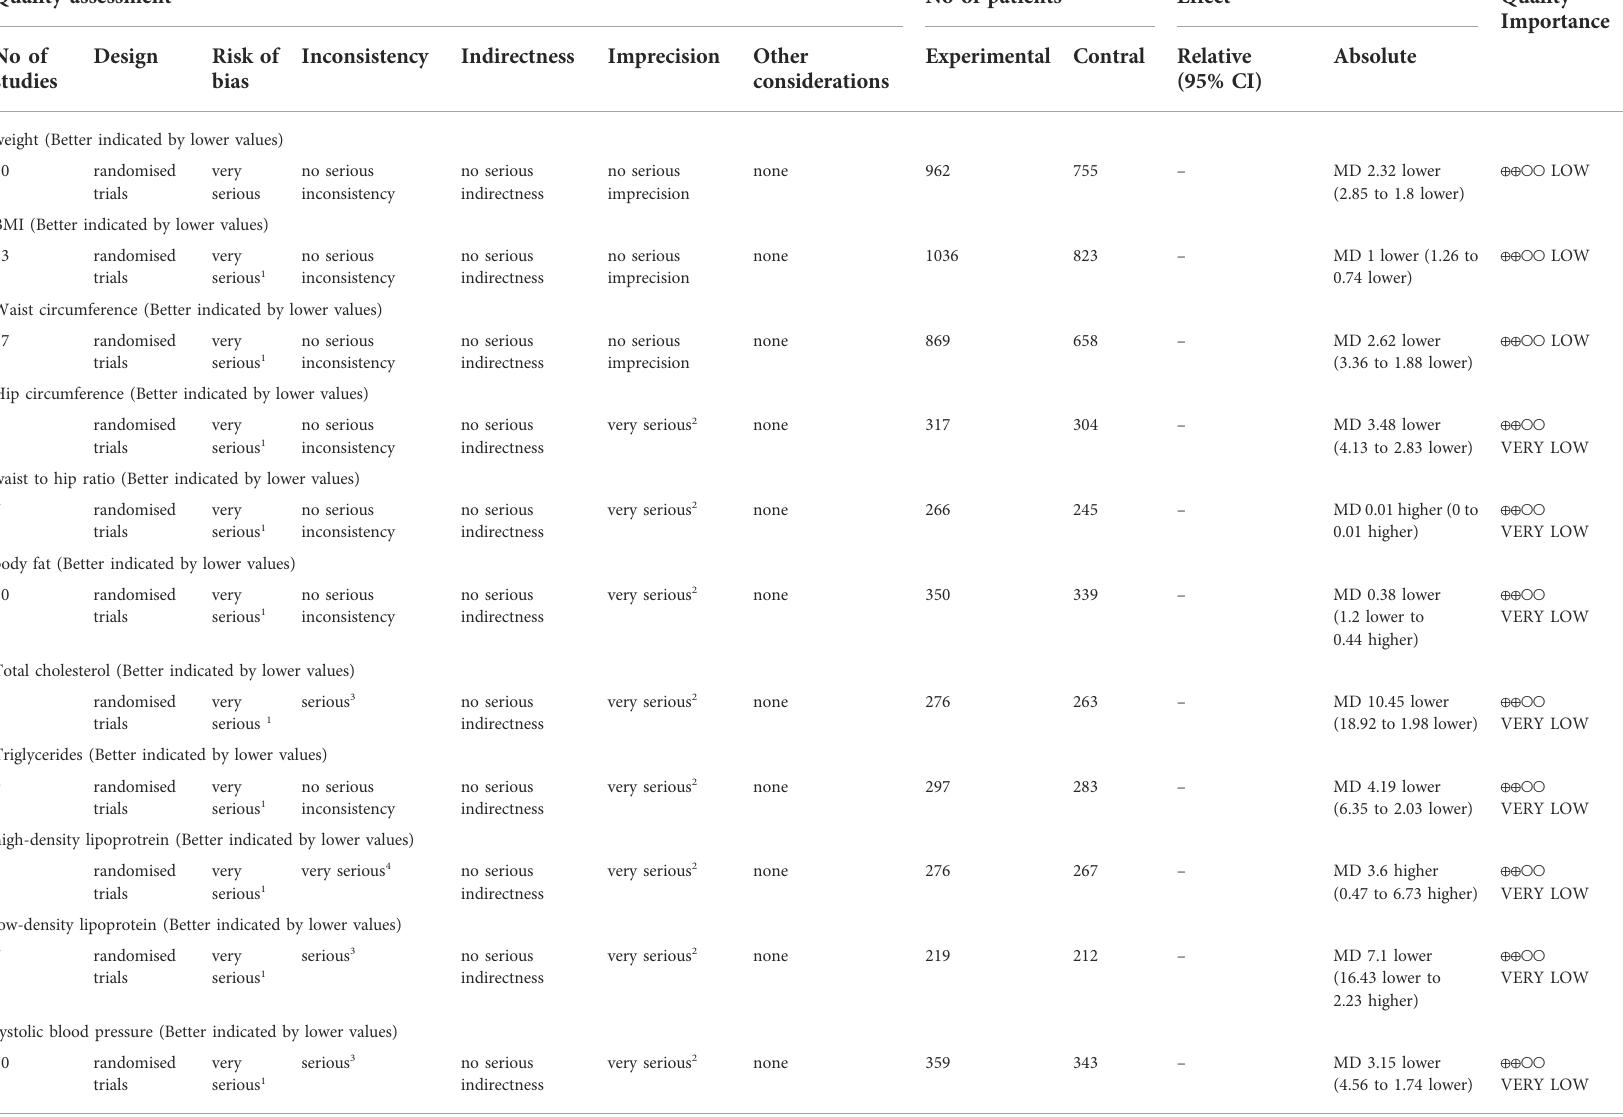
TABLE 3 Grade of the